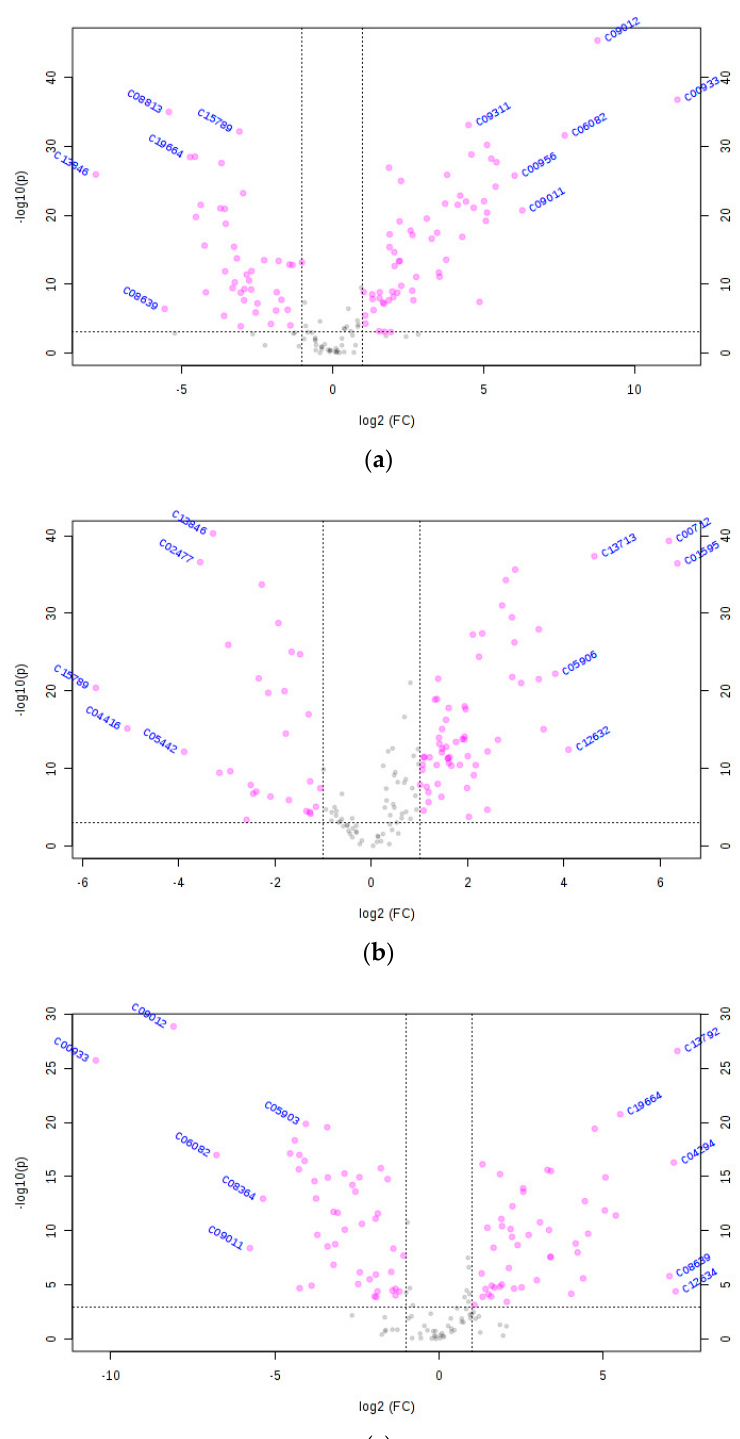
Figure 2. Different metabolites for Chinese and Canadian rapeseeds ( a ), Chinese and Mongolian rapeseeds ( b ), and Canadian and Mongolian rapeseeds ( c ) selected by volcano plot with fold change (FC) threshold (x) 2 and t -test threshold (y) 0.001. The FC and p- values were both log transformed. The red circles on the left represent metabolites above the thresholds and their contents were up-regulated in Canadian rapeseeds compared with Chinese rapeseeds ( a ), in Mongolian rapeseeds compared with Chinese rapeseeds ( b ), and in Mongolian rapeseeds compared with Canadian rapeseeds ( c )while the red circles on the right were the opposite. The grey circles represent metabolites with no significant di ff erence. The further its position away from (0,0), the more significant the metabolite